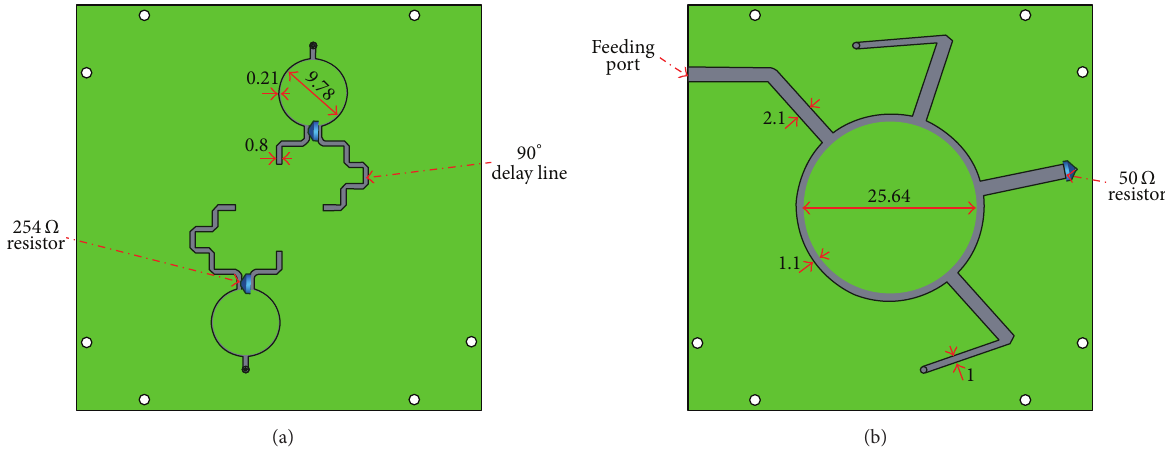
Figure 5: Geometry of the feed network (item: mm). (a) Downward view of the upper substrate, (b) bottom view of the lower substrate.